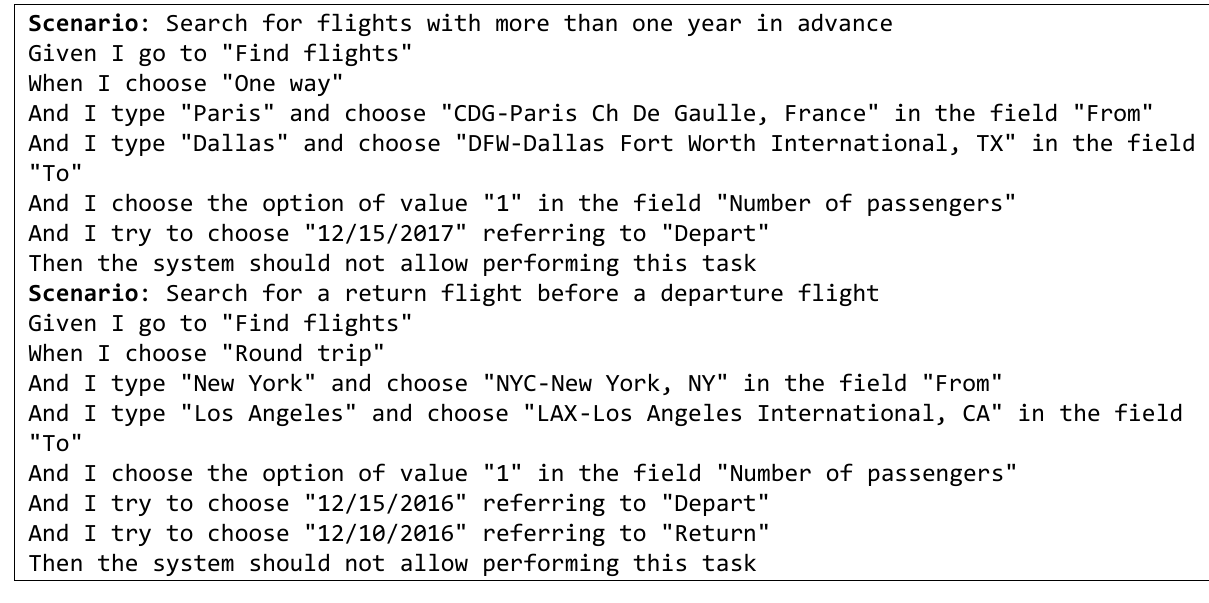
Figure 12. Two Scenarios added to the User Story for Flight Ticket